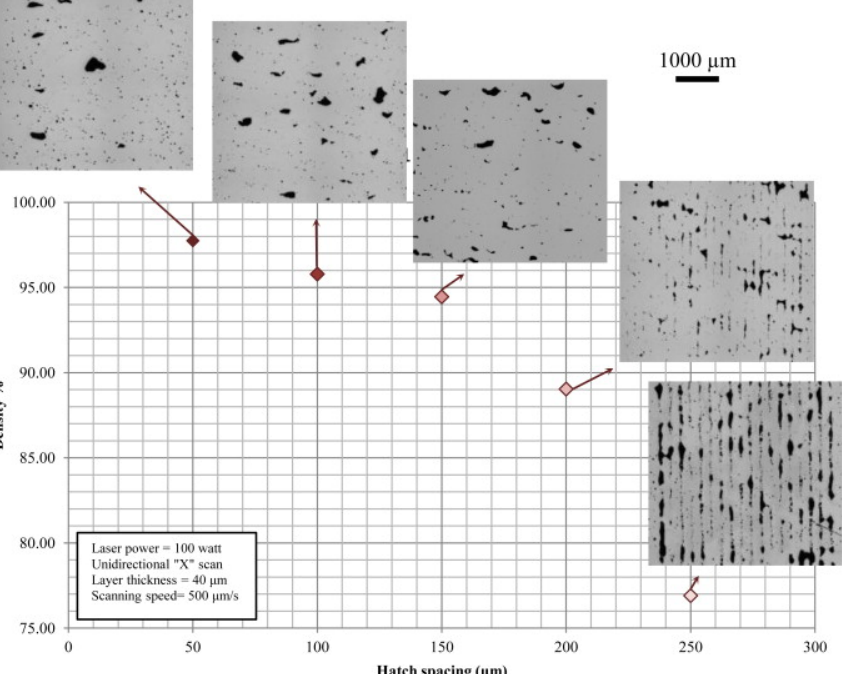
Figure 38. Evolution of pores in AlSi10Mg processed by SLM as a function of varying hatch spacing [76]. Copyright 2014. Adapted from Elsevier Science Ltd. (Figure 4 [76]). Copyright 2014. Adapted from Elsevier Science Ltd. (Figure 4